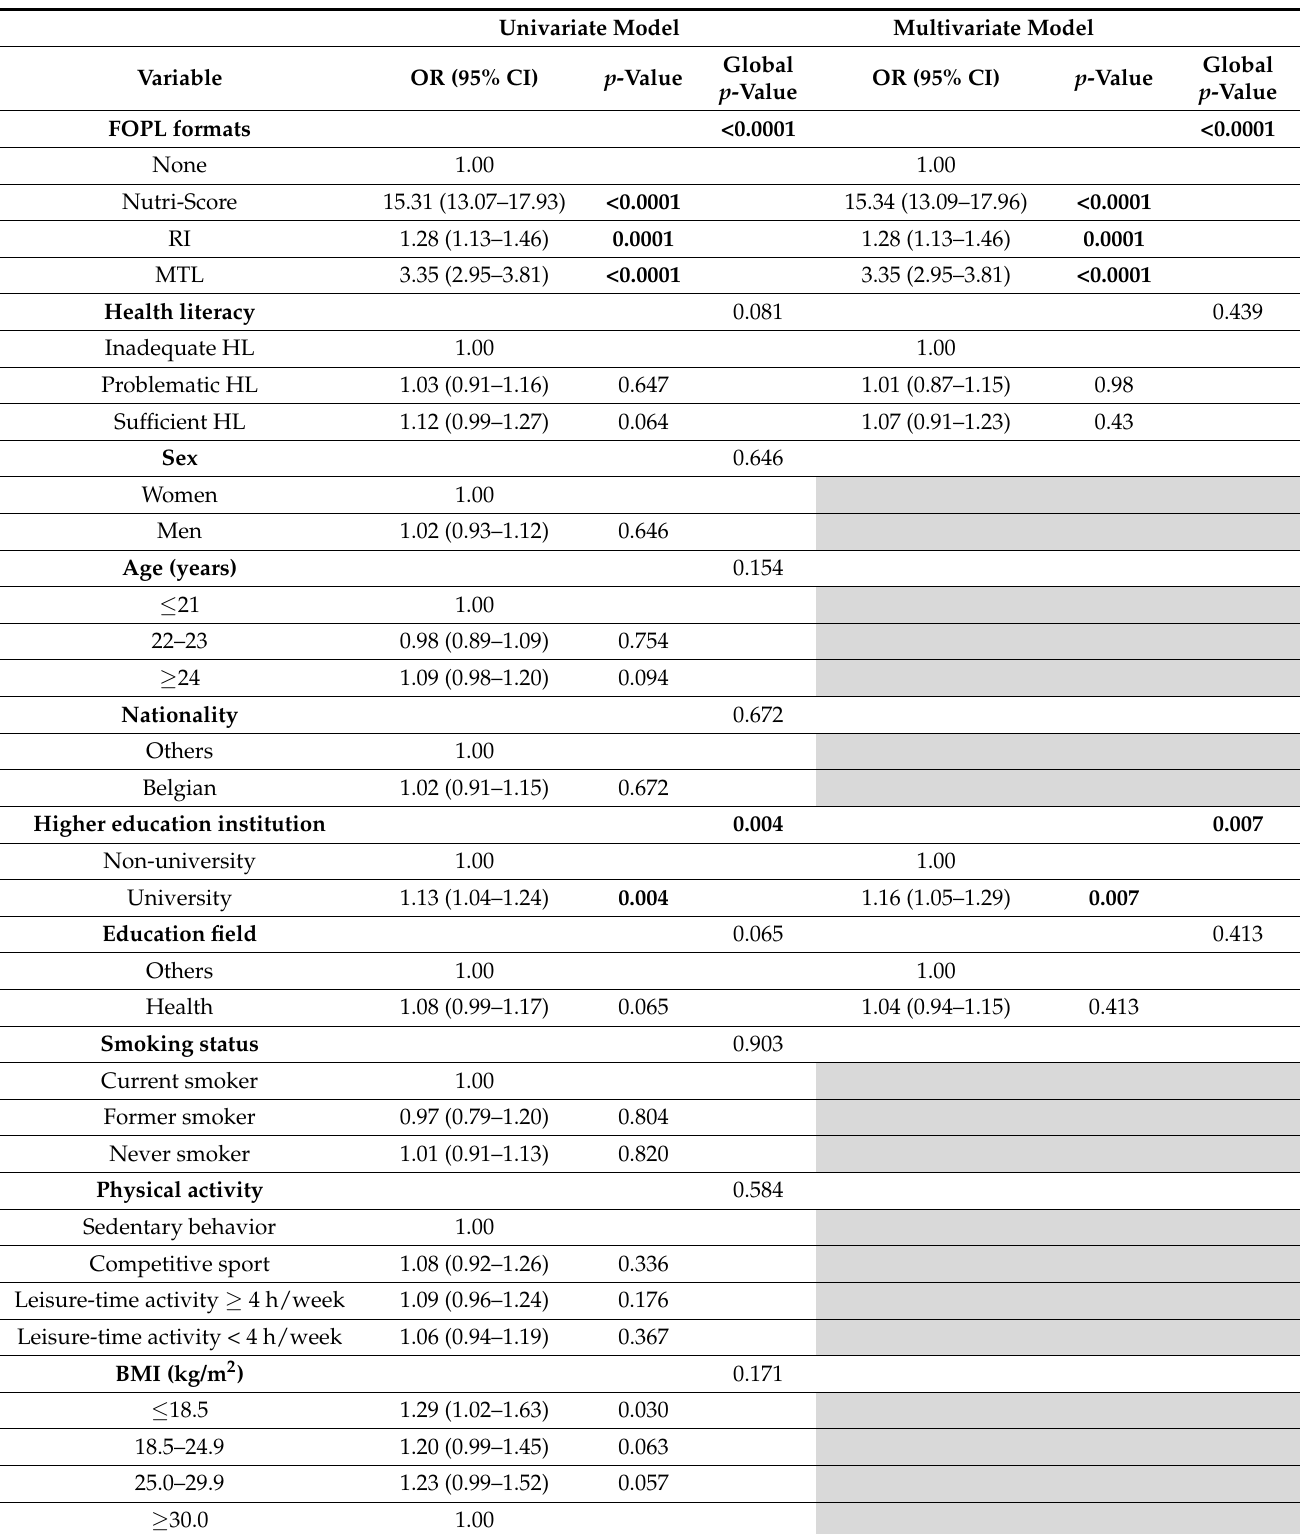
Table 2. Univariate and multivariate mixed logistic regression models showing the association between objective understanding and FOPL formats, HL, and other students’